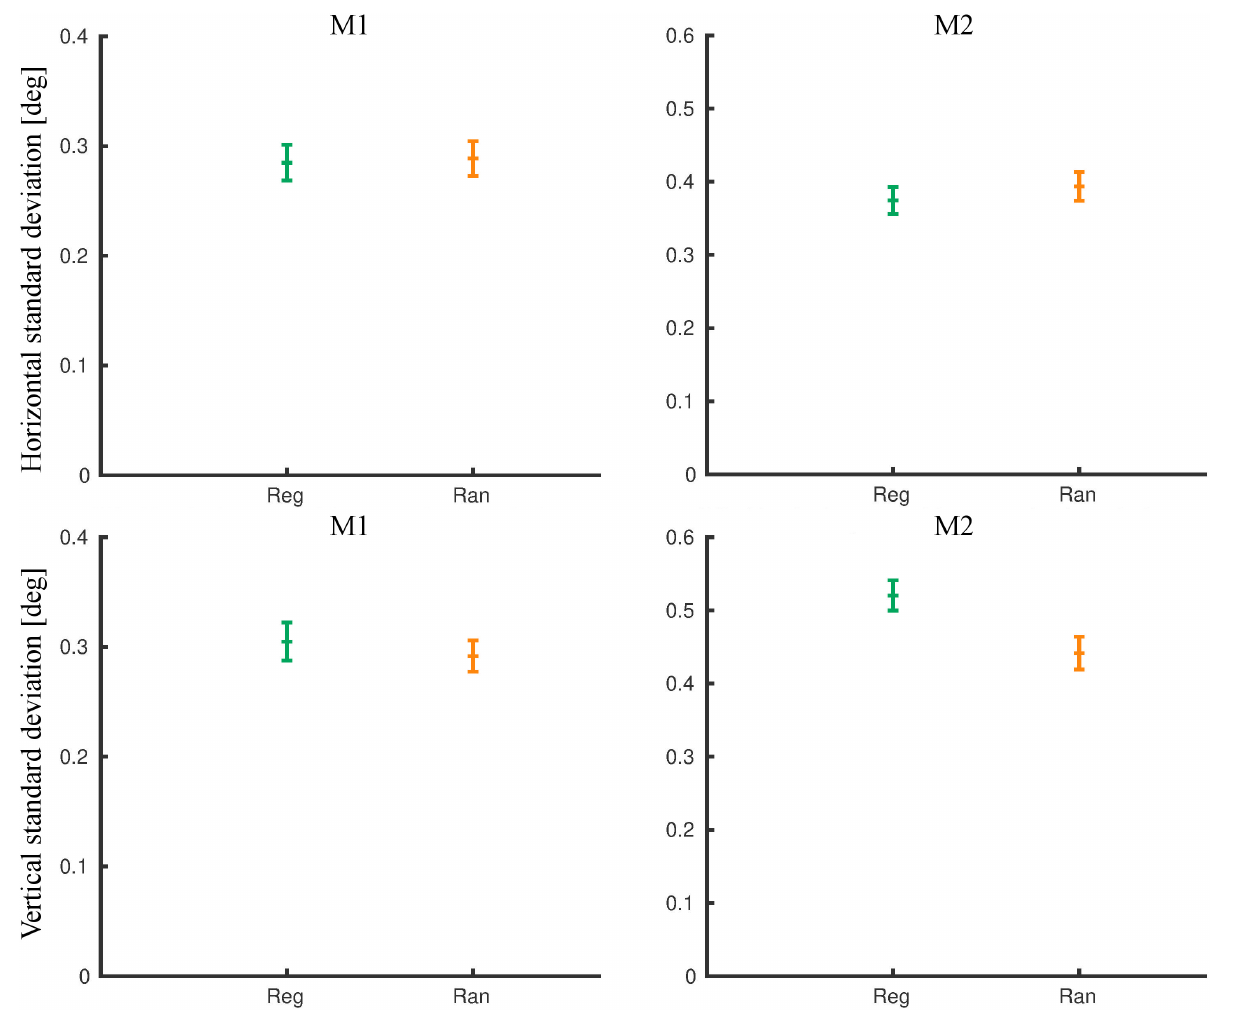
FIGURE 6 | Eye movement metrics during functional MRI (fMRI) for the same runs that were employed for the fMRI analysis. The standard deviations of the eye position outside the blink epochs were computed per block for the horizontal (top) and the vertical dimensions separately. The means and 95% confidence intervals for the regular (Reg) and random (Ran) sequences are plotted for monkey M1 and